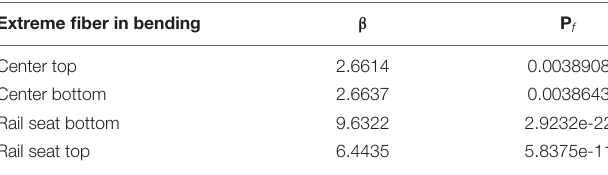
TABLE 4 | Reliability index and probability of failure for the studied limit state functions obtained using FORM. Extreme fiber in bending β P f Center